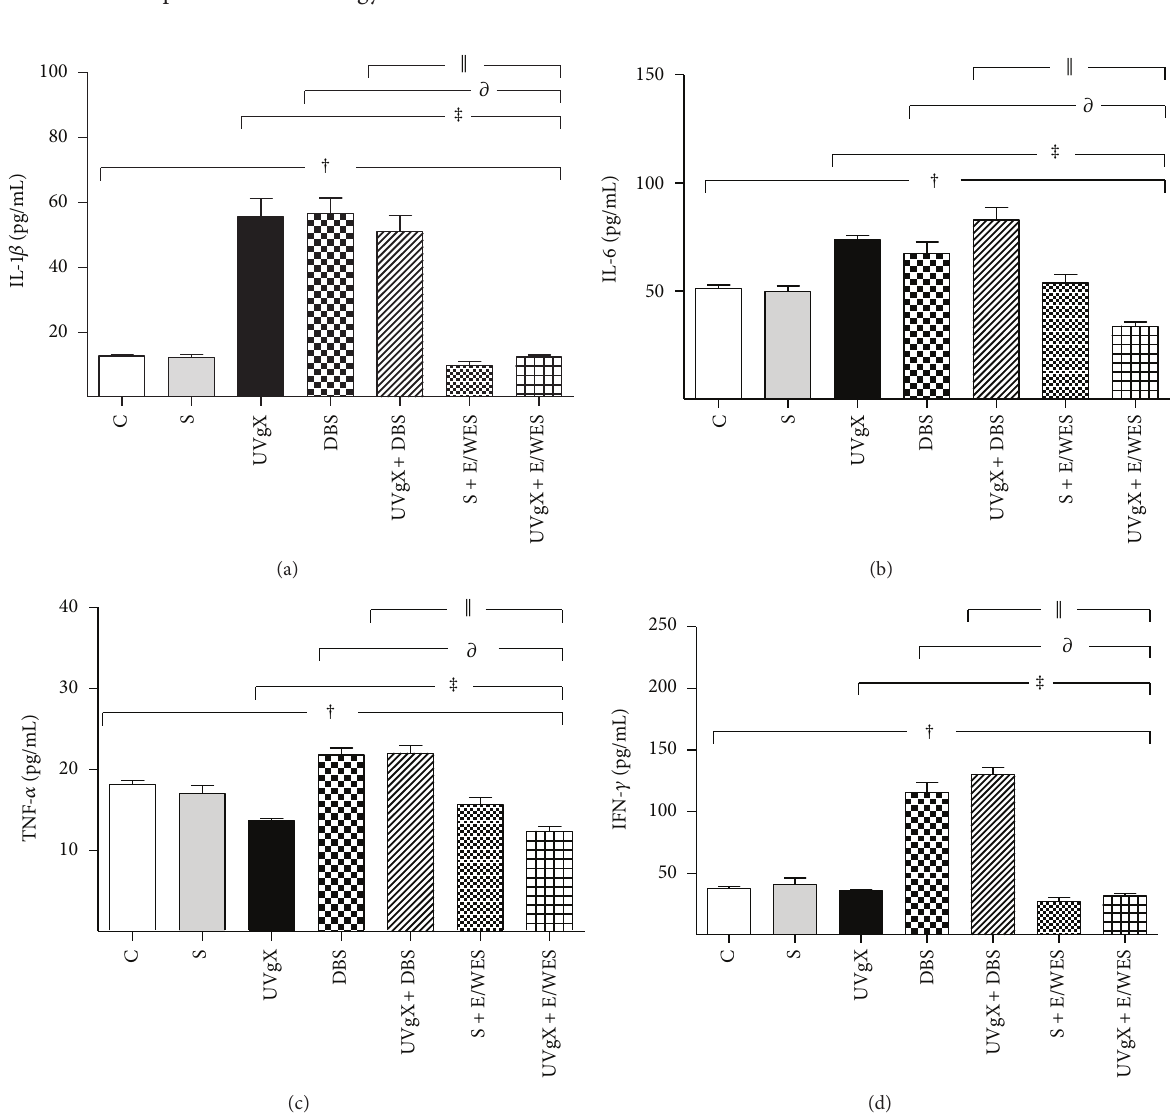
Figure 2: Effect of unilateral vagotomy and deep brain stimulation of hypothalamic nucleus on cytokine levels in Wistar rats. Serum IL- 1 𝛽 , IL-6, TNF- 𝛼 and IFN- 𝛾 , levels were detected by capture ELISA assay. Animals received the following experimental procedures; Sham (S): animals were operated to expose the vagal trunk, without cutting the vagus nerve. Sham plus electrodes/without electric stimulation (S + E/WES). Unilateral vagotomy (UVgX): right vagus nerve was carefully separated from the carotid artery and cut. Unilateral vagotomy plus electrodes/without electric stimulation (UVgX + E/WES). Deep brain stimulation (DBS): animals were implanted bilaterally with two electrodes. Unilateral vagotomy plus deep brain stimulation (UV + DBS). Animals without treatment (C). Experimental groups ( 𝑛 = 6 rats) were followedup 21 days and showed significant differences compared to C, S, UVgX, DBS, and UVgX + DBS. Data are expressed as mean ± SE. The differences between means were evaluated with one-way ANOVA with Bonferroni’s post hoc. Statistical significance was attributed when 𝑃 < 0.05 . † 𝑃 < 0.001 C or S versus UVgX, DBS, UVgX + DBS, S + E/WES, and UVgX + E/WES groups; ‡ 𝑃 < 0.001 UVgX versus DBS,